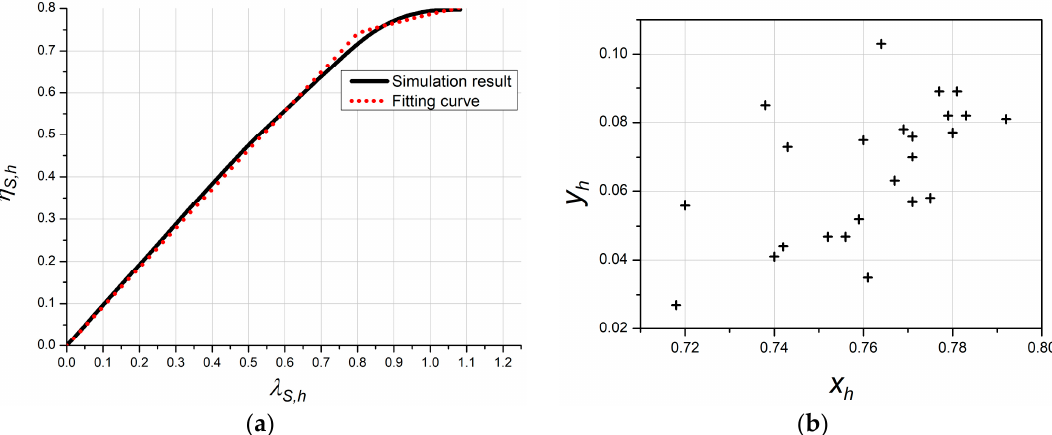
Figure 13. The high load results. ( a ) Comparison between the simulation result and the fitting curve; ( b ) scatterplot of coefficients, x h and y h .